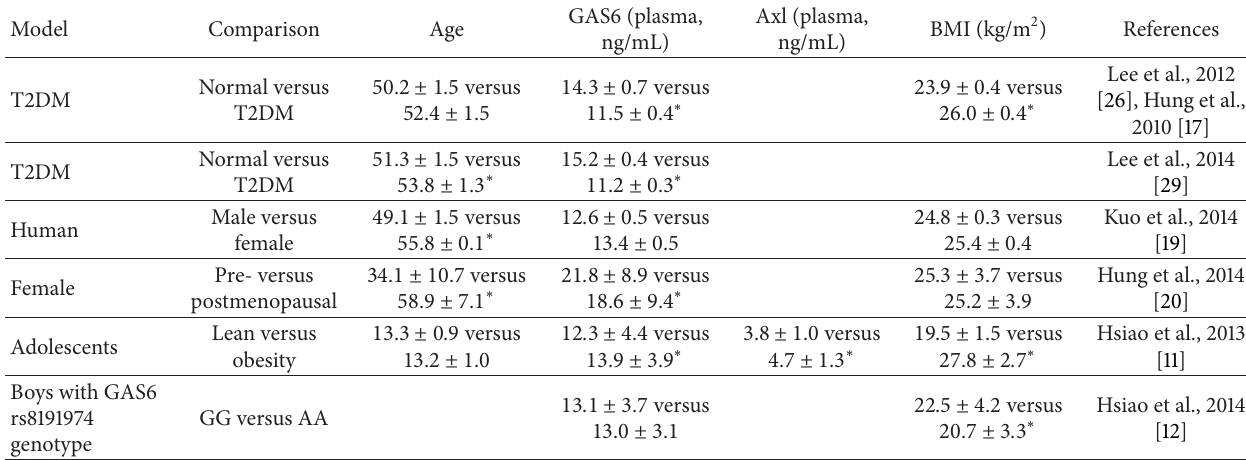
Table 2: GAS6 signaling molecules and the development of obesity in clinical studies.